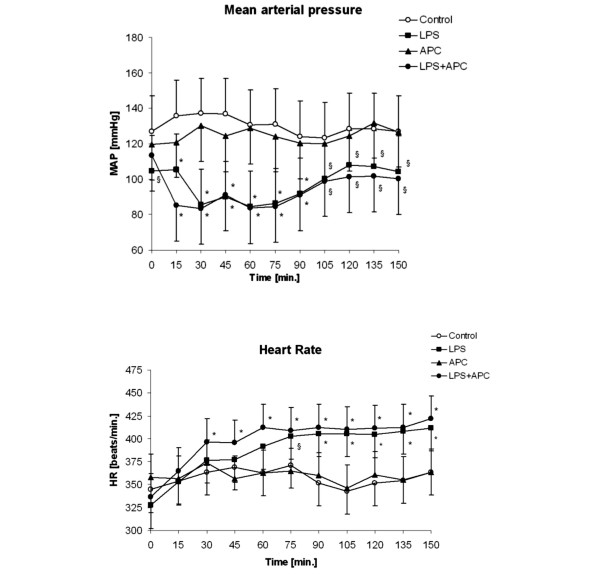
Haemodynamic data. Mean arterial pressure (a) and heart rate (b). *p < 0.01 versus control; §p < 0.05 versus control. APC, activated protein C-only group; LPS, lipopolysaccharide-only group; LPS + APC, activated protein C-treated endotoxaemic group; MAP, mean arterial pressure.